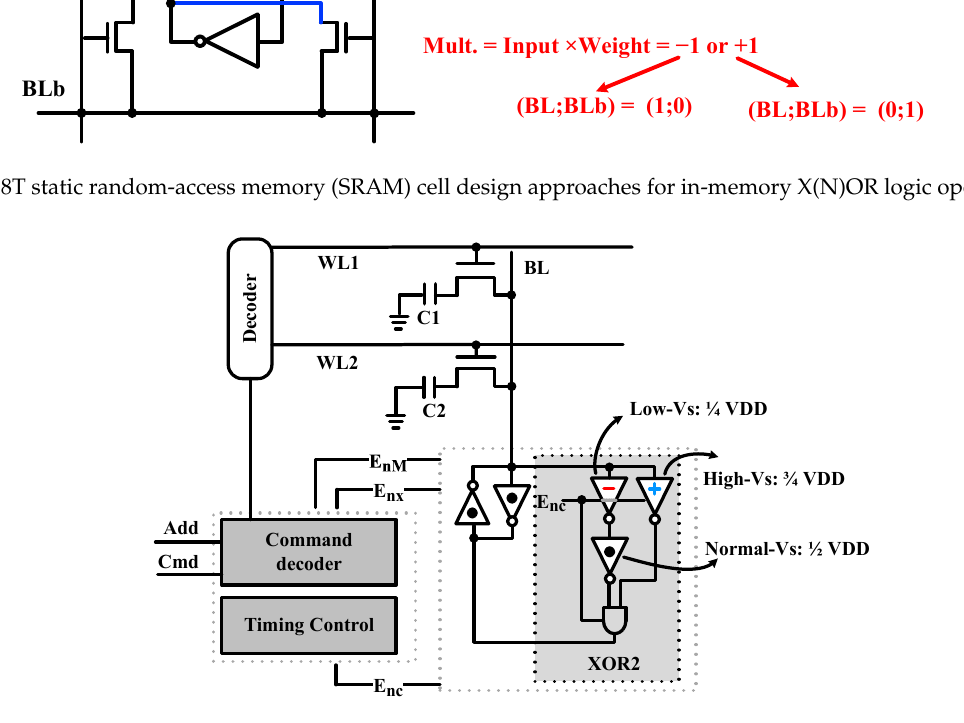
Figure 2. The reconfigurable sense amplifier is used to implement logic operations. Reprinted with permission from ref. [26]. Copyright @ 2019 IEEE. permission from ref. [26]. Copyright @ 2019